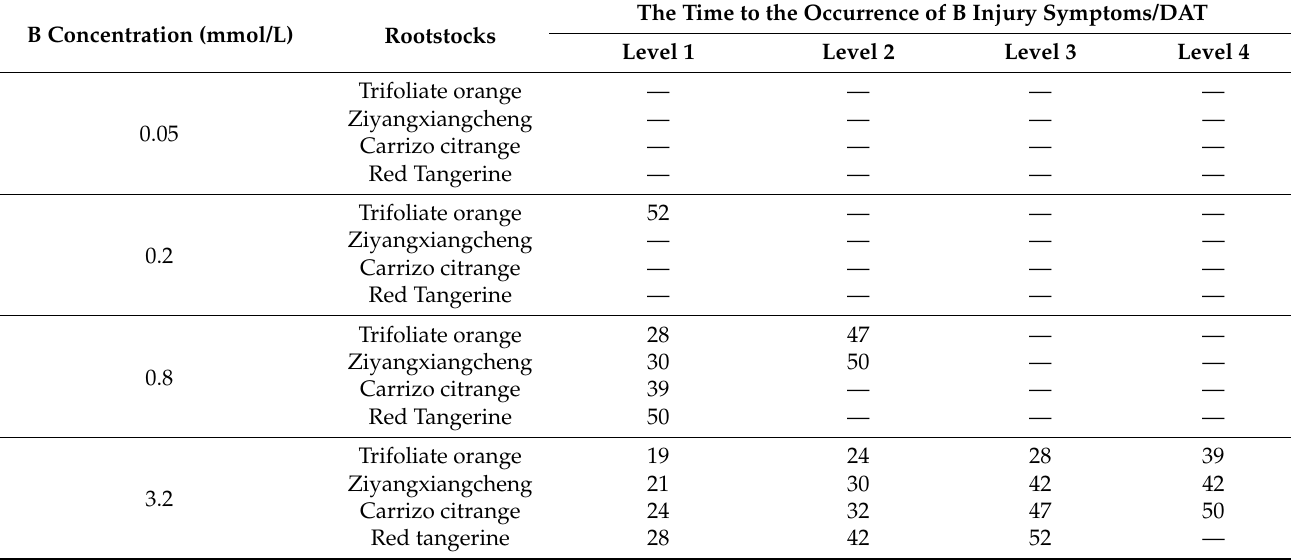
Over the treatment period, all rootstocks grew readily under control (B 0.05) conditions, and Trifoliate oranges were the only rootstock to exhibit mild symptoms of B toxicity under the B 0.2 treatment conditions (Table 1). As such, B injury index values for these rootstocks were only calculated for the B 0.8 and B 3.2 treatment conditions (Table 2). These analyses revealed significant differences in B injury indices among these different citrus rootstocks. while respective values for Carrizo citrange and Red tangerine were just 61.25% and 48.75%. When B concentrations were increased from 0.8 to 3.2 mmol/L, the B injury index values for Trifoliate orange and Red tangerine at 52 DAT rose by 53.75% and 42.5%, respectively. Table 2. B injury index values for four citrus rootstock seedlings grown under excess B stress conditions. B Concentration (mmol/L)